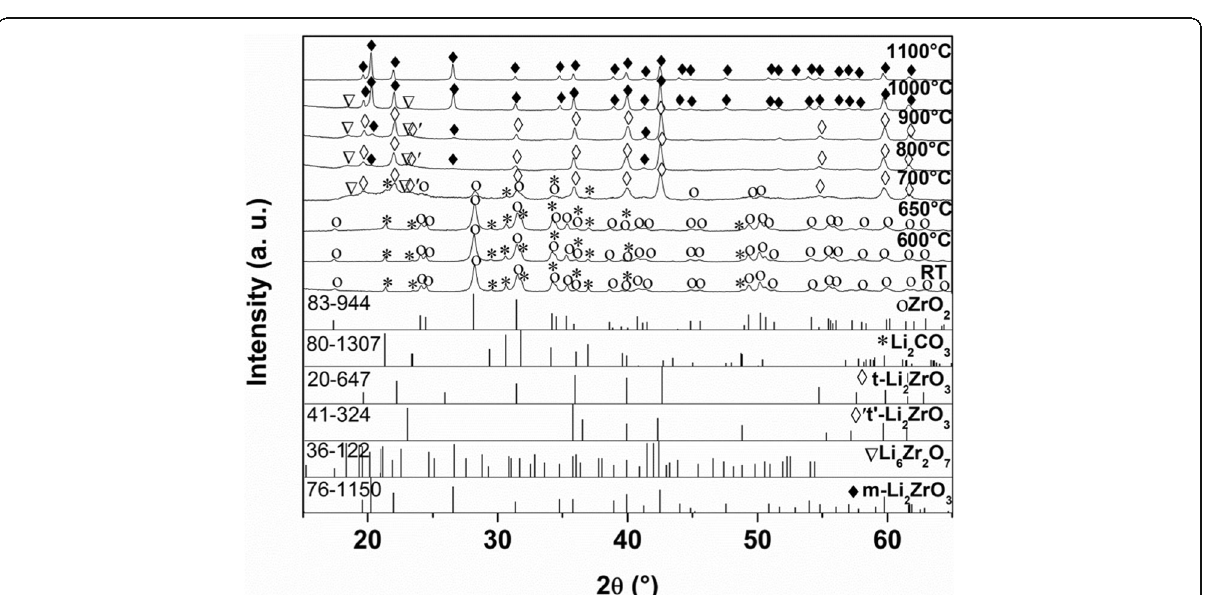
Fig. 1 XRD patterns of Li 2 CO 3 -ZrO 2 mixtures at room temperature (RT) and heated at different